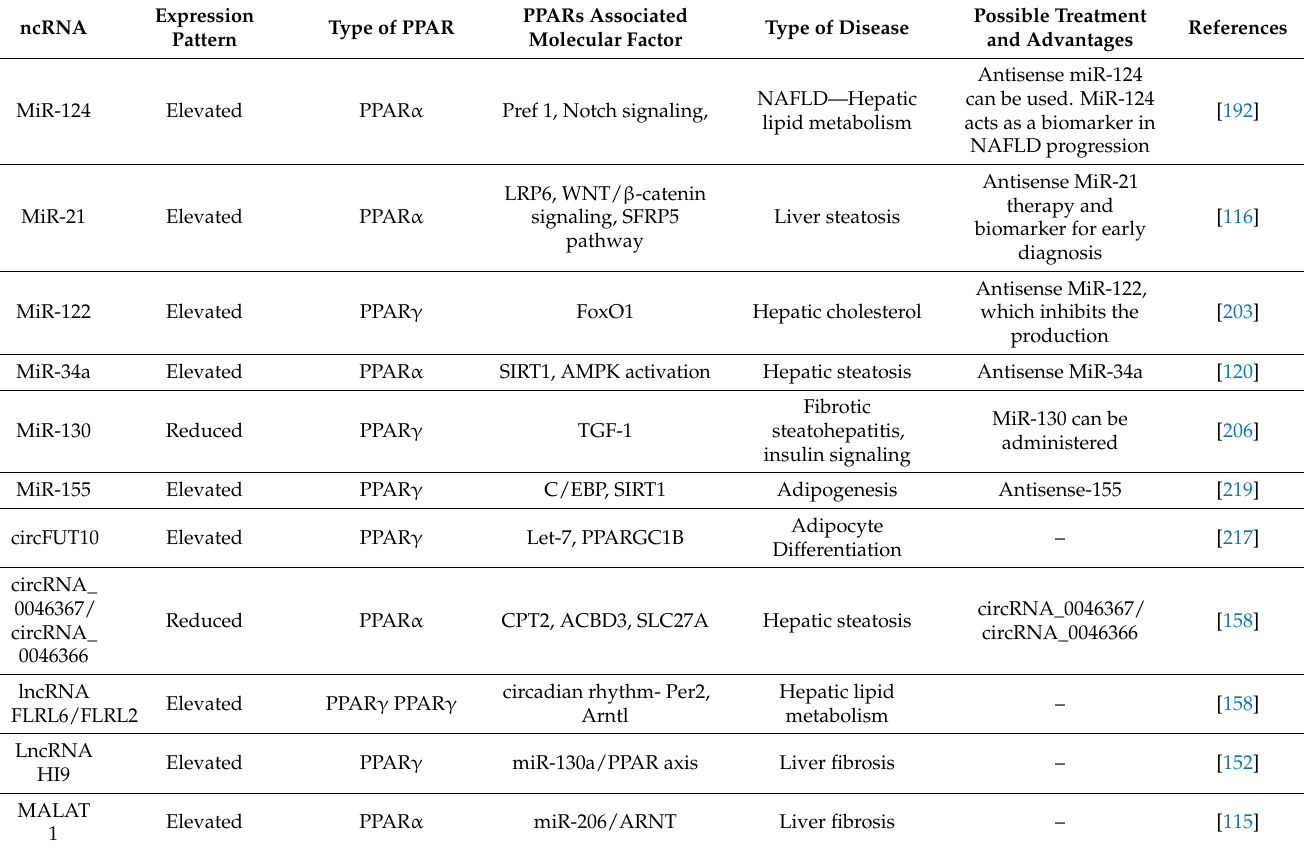
Table 2. Pathway and proteins involved in PPARs-related ncRNA in NAFLD and the possible treatment